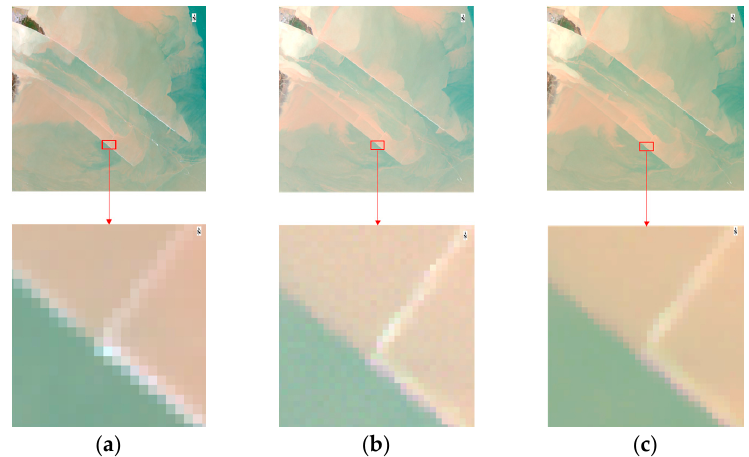
Figure 6. RGB image of: ( a ) Landsat-8/OLI (channels 4-3-2) L TOA ; ( b ) Raw GF-1/WFV (channels 3-2-1) L TOA ; ( c ) GF-1/WFV (channels 3-2-1) L TOA after sliding window smooth. Images are acquired at same date (4 November 2014), upper figure is the deep-water channel shown in Figure 4c (red solid box in Figure 4a) and lower figure is the zoom-in of the red box in upper figure. Comparison on pixel values of WFV LTOA before and after the filtering process is shown in Figure 7, the pixels are within three sampling regions shown in Figure 4a (dashed black box). The regression line (dashed red line) are slightly differed from the 1:1 line (dashed blue line) for all bands indicates that the WFV LTOA have small changes after the filtering process.